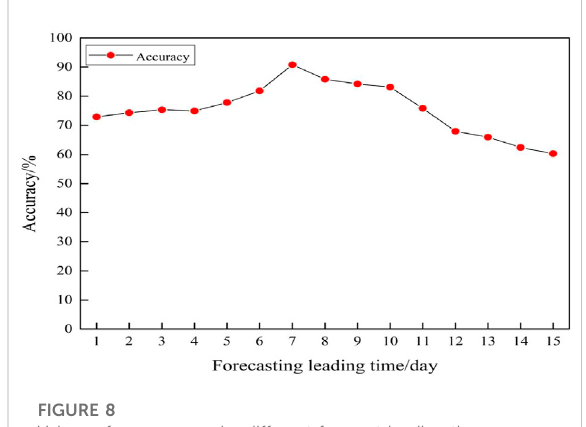
Frontiers in Earth